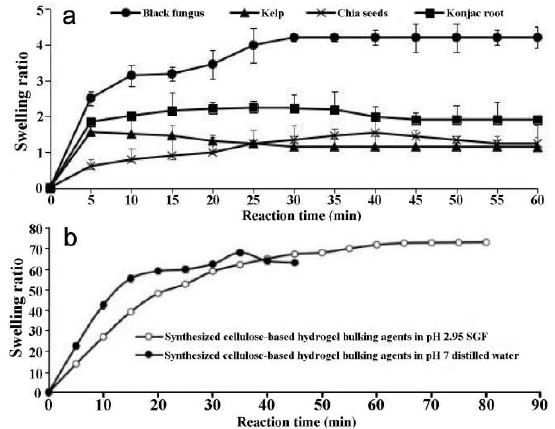
Figure 2. Black fungus inside the casing and the gelatin capsule after shaping in the 3D printed Figure 3. Swelling as function of time of natural and synthesized expandable materials. ( a ) The molds. The photos are from taken at 0, 5, 10, 15, 20, 30, 40, 50, and 60 min. The final expanded size swelling ratio of four natural expandable materials: dried black fungus, chia seeds, konjac root, and was 2.5 cm in diameter. kelp for 60 min in pH 2.95 simulated gastric fluid. ( b ) The swelling ratio of synthesized cellulose- based hydrogel bulking agents in pH 7 distilled water and pH 2.95 simulated gastric fluid.